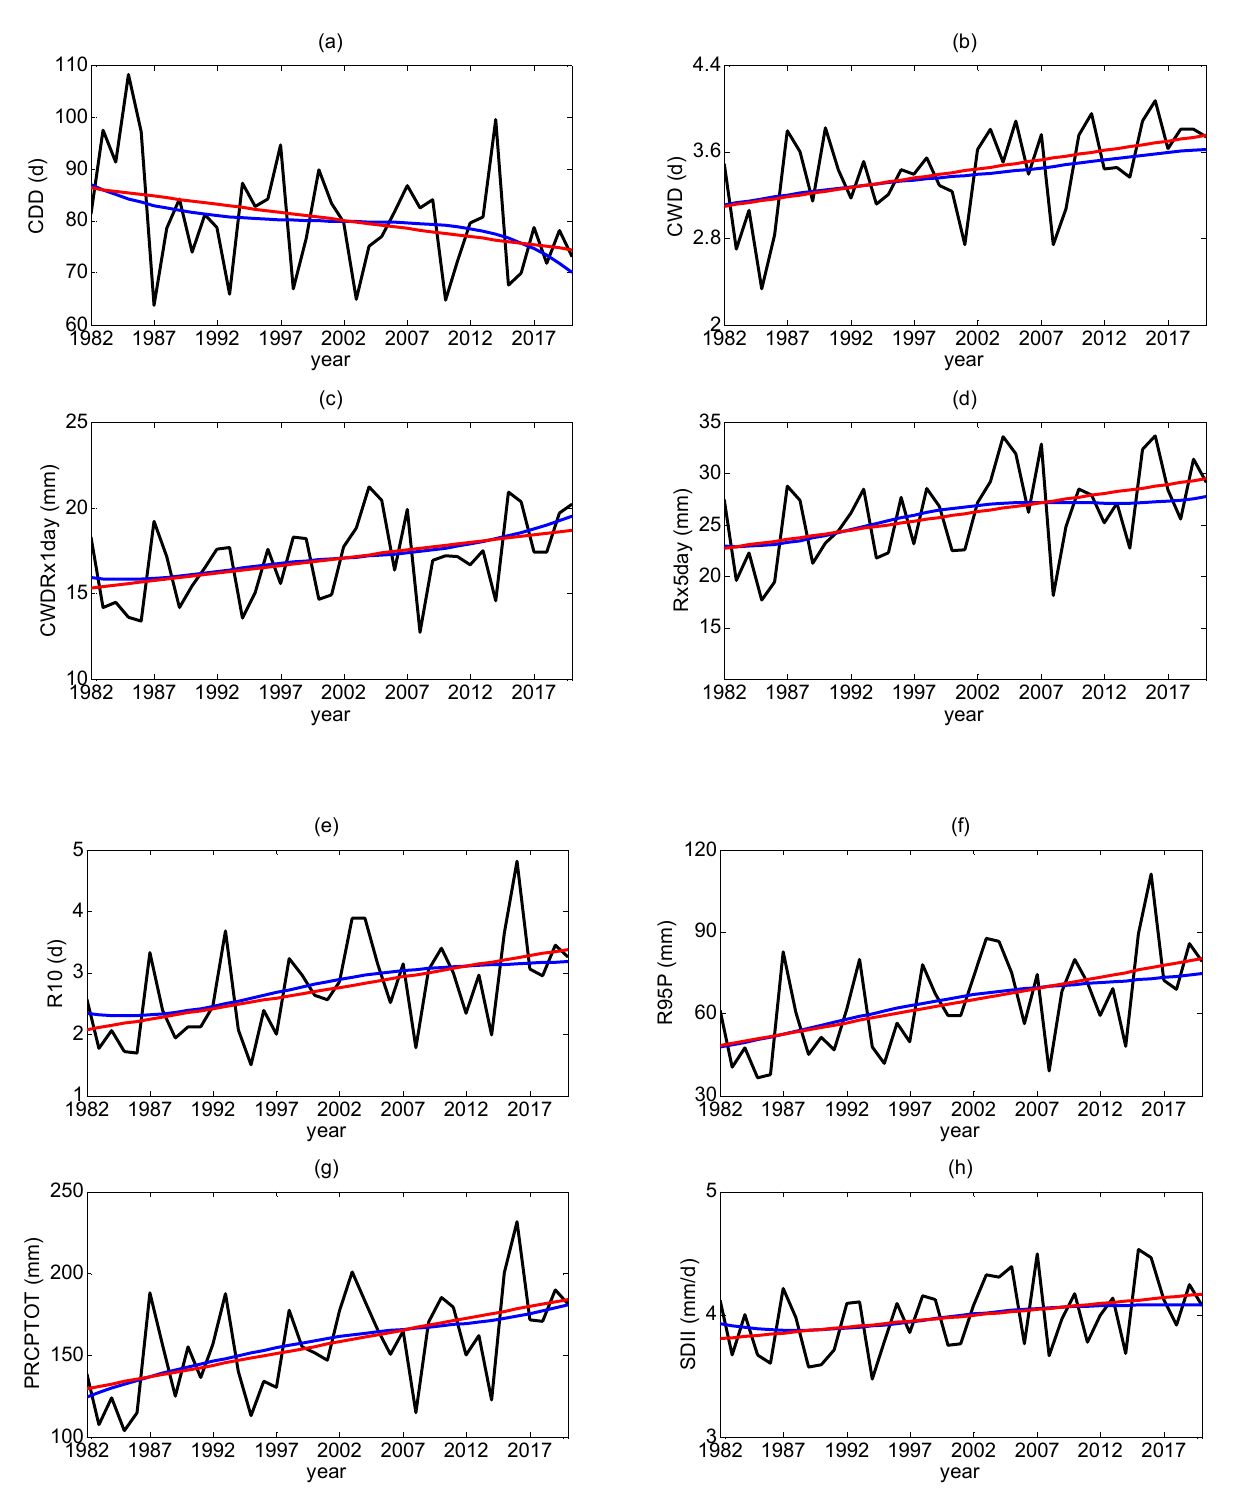
Figure 4. Annual series of regional mean extreme precipitation indices during 1982–2020 (black line). Red and blue lines indicate linear and nonlinear trends, respectively: ( a ) CDDs; ( b ) CWDs; ( c ) Rx1day; ( d ) Rx5day; ( e ) R10; ( f ) R95P; ( g ) PRCPTOT; ( h ) SDII.